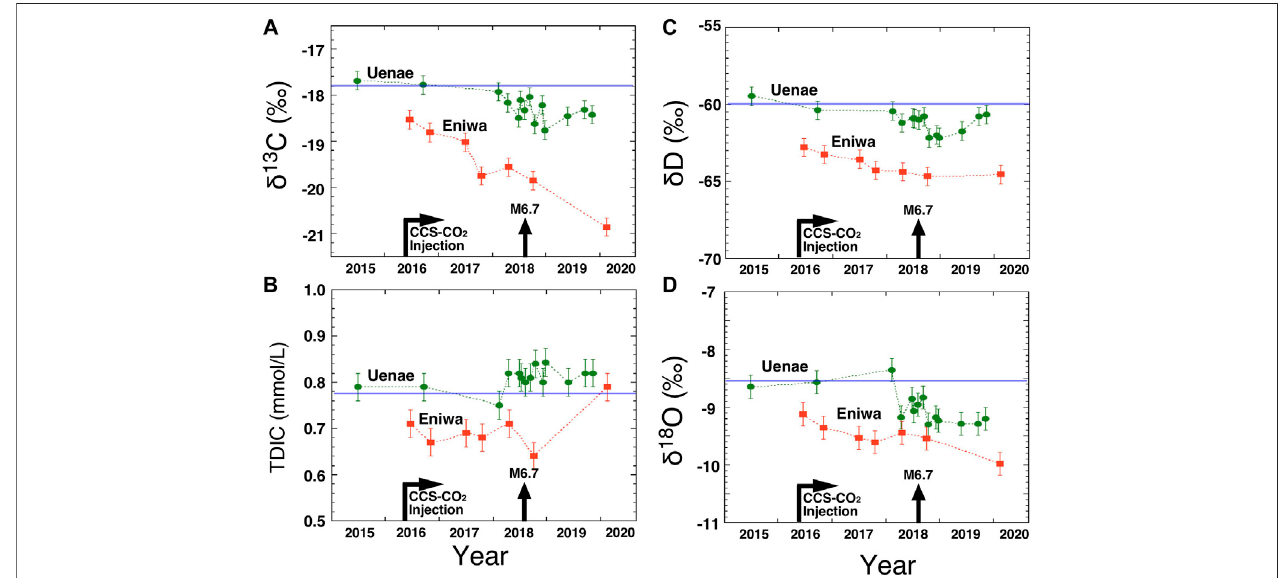
FIGURE 2 | Temporal variations of (A) δ 13 C values of total carbonate in mineral water (B) total dissolved inorganic carbon (TDIC) concentration (mmol/L), (C) δ 2 H, and (D) δ 18 O values of mineral water. Error bars show 2 σ values. Blue lines represent averages of three samples (2015, 2016, and april 2018) from the Uenae well. Start dates of CCS-CO 2 injection and origin time of M6.7 earthquakes (M6.7 in Figure 1 ) are indicated by arrows in (A) and (D) .